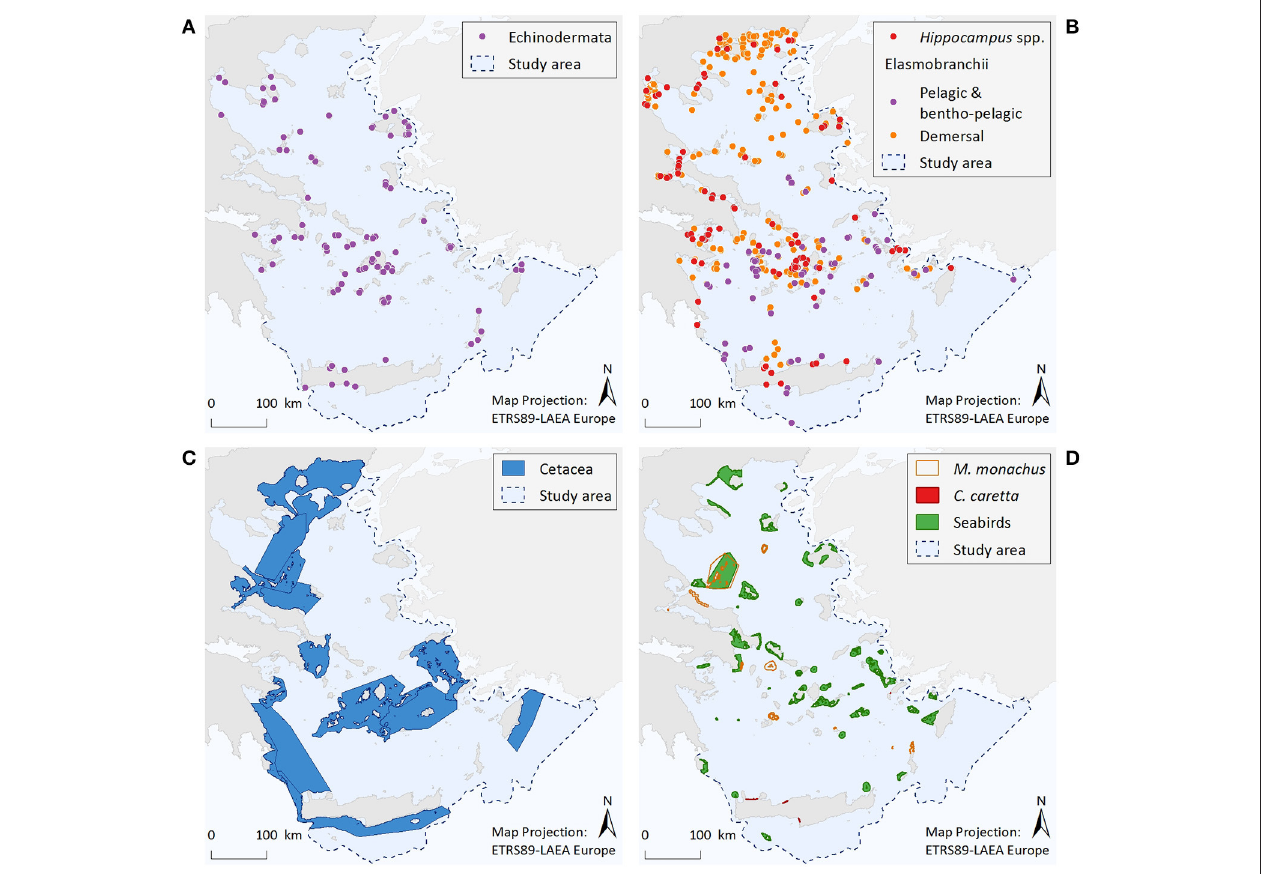
FIGURE 3 | Illustrative maps depicting the distribution of (A) Echinodermata, (B) Hippocampus spp. and Elasmobranchii, as well as important areas for (C) Cetacea, and (D) Monachus monachus, Caretta caretta, and seabirds.